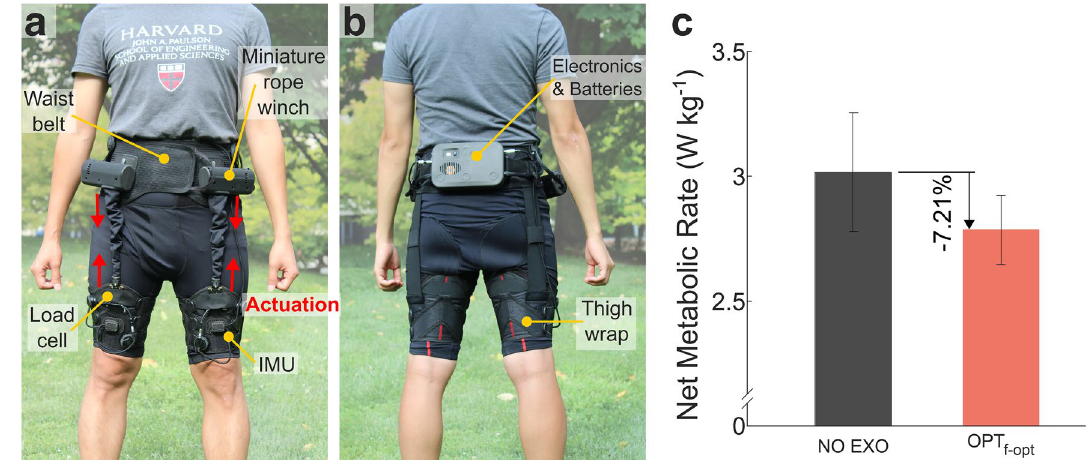
Figure 6. Autonomous hip flexion system & metabolic results. ( a and b ) Components of the autonomous and portable hip flexion exosuit. The front ( a ) and rear ( b ) view of the portable exosuit. ( c ) Metabolic results for portable exosuit with optimal timing ( OPT f − opt ) compared to normal walking ( NO EXO ). (n = 3; P2, P7, and P8 in Fig. 2 were